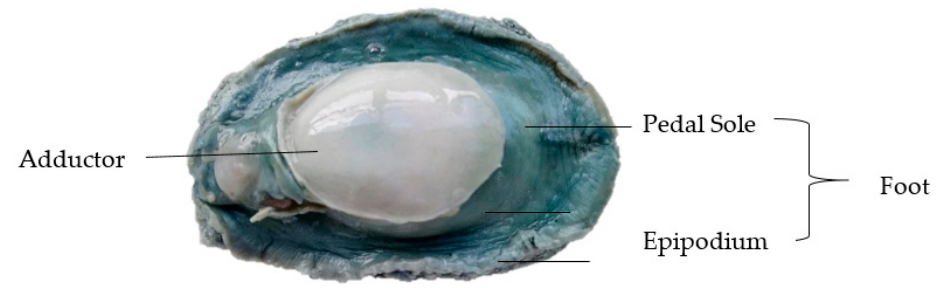
Figure 1. Raw untreated p ā ua.